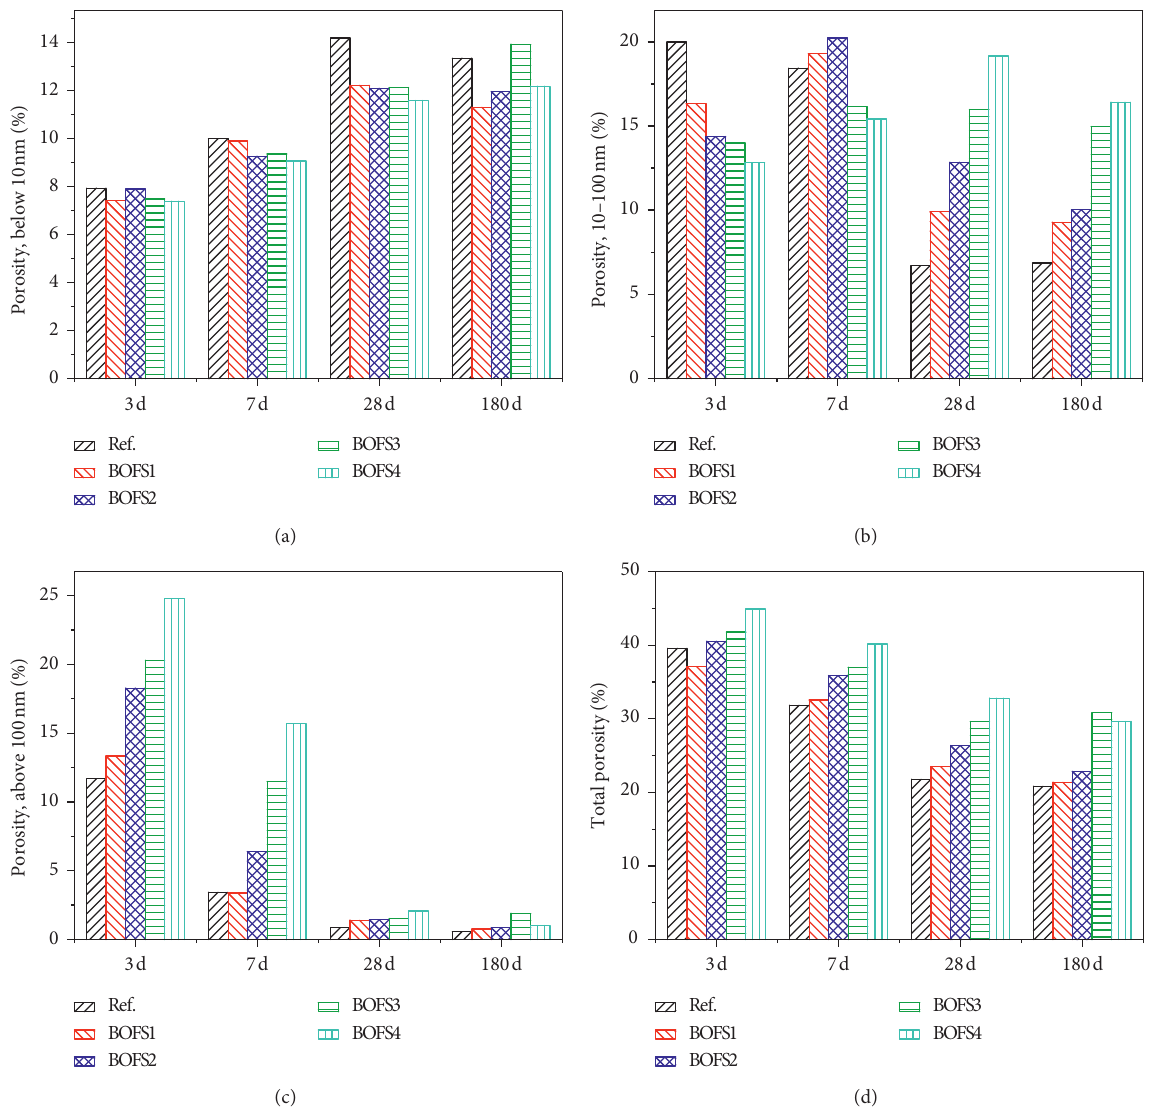
Figure 5: Absolute porosity in pore range below 10nm, between 10–100nm, and above 100nm for cement pastes with BOFS. Table 3: Relative pore volume fraction of BOFS-blended composites.